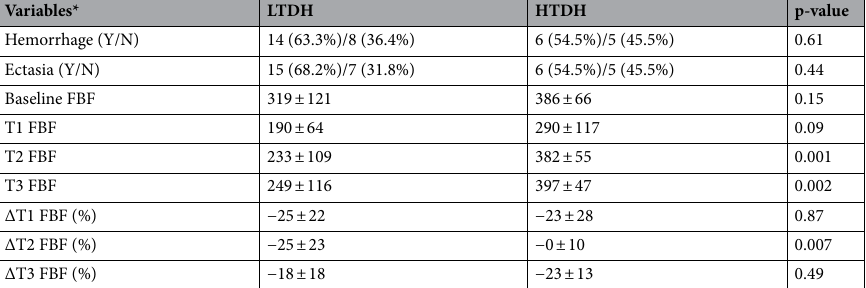
Table 2. Mean fingertip blood flow measured using laser Doppler imaging and capillaroscopy analysis in patients with low- and high-tension optic disc hemorrhages. LTDH, low-tension optic disc hemorrhages; HTDH, high-tension optic disc hemorrhages; Y, with hemorrhage/ectasia; N, without hemorrhage/ectasia; NC, nailfold capillaroscopy; FBF, mean fingertip blood flow; T1/T2/T3, 1/10/20 min after the cold stimulus, respectively; Δ, percentage difference between post- and pre-cold stimulus. *Data are given as mean ± standard deviation or number (percentage).